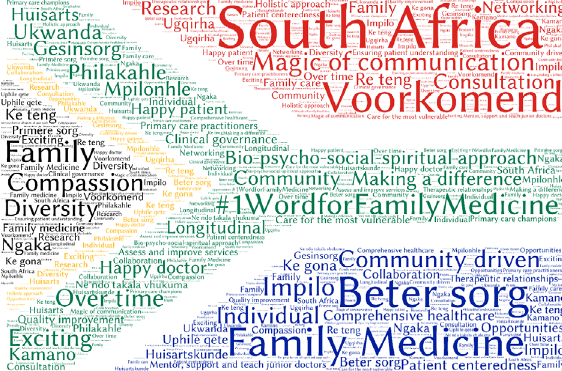
Figure 1: The first selected #1WordforFamilyMedicine South Africa image, based on the national flag